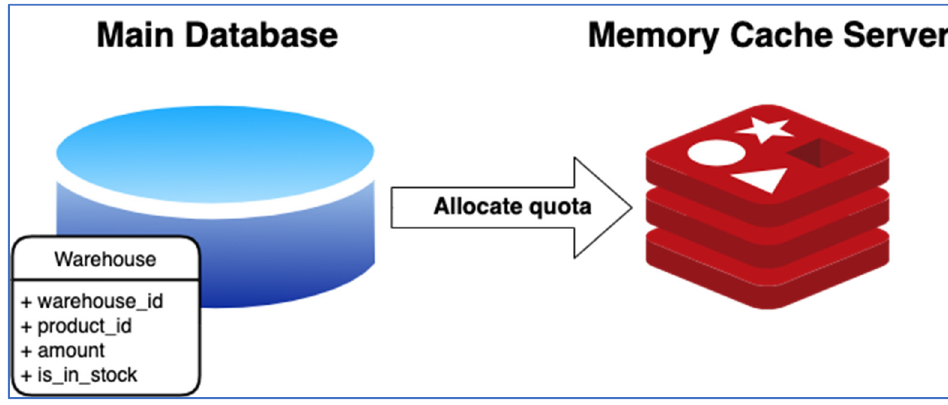
Figure 5. Quota cache